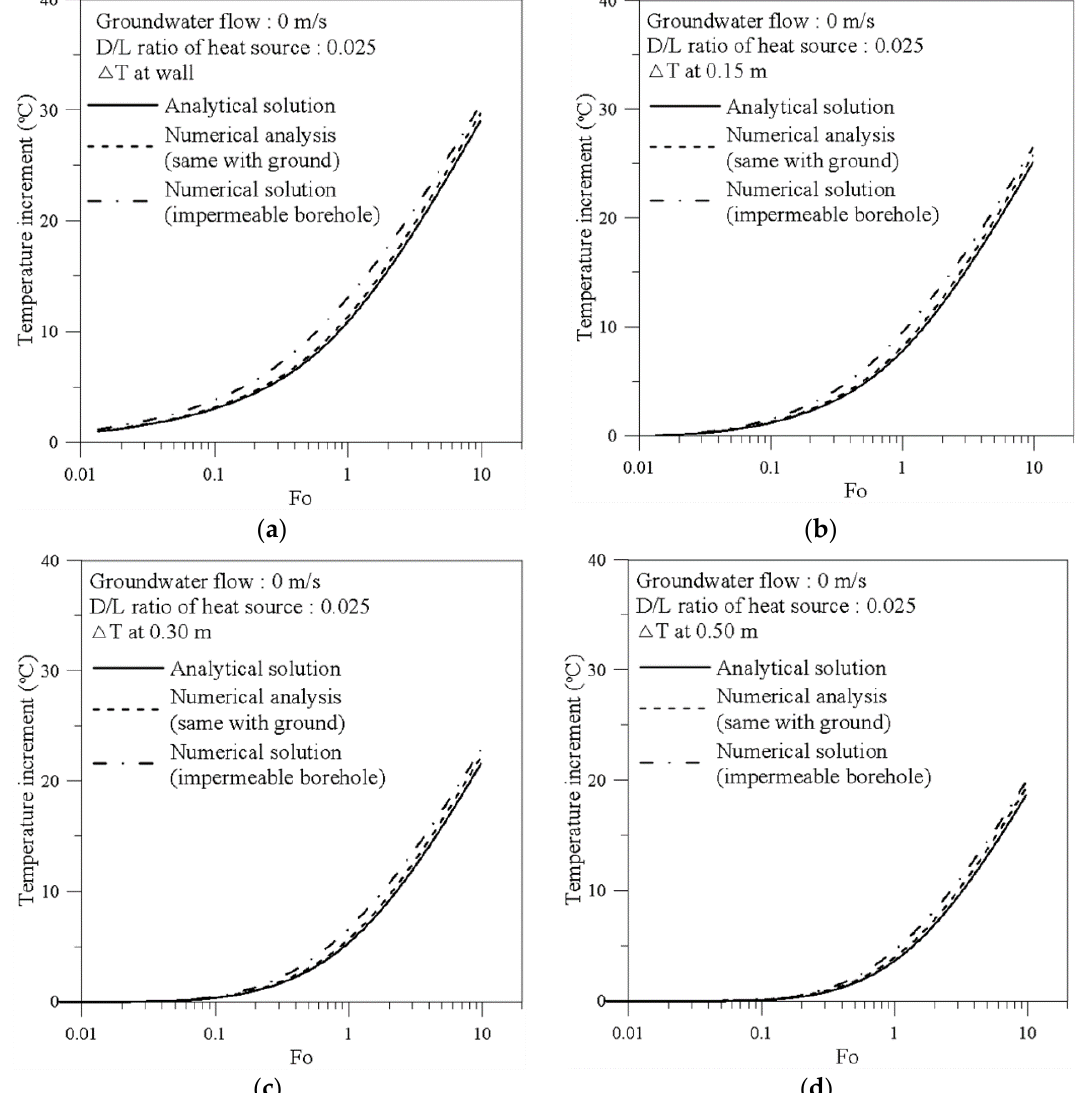
Figure 5. Comparison of analytical solution and numerical analysis results (u = 0 m/s, D/L ratio = 0.025). Temperature increment at ( a ) wall; ( b ) 0.15 m; ( c ) 0.30 m; ( d ) 0.50 m.